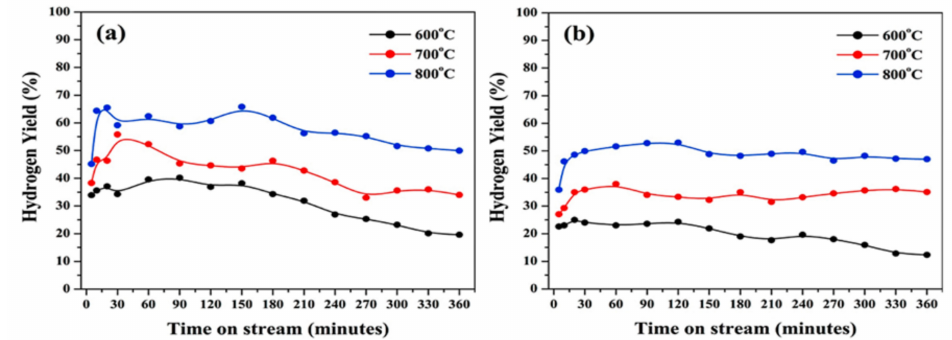
Figure 12. Catalytic activity tests carried out using ( a ) a NiO catalyst and ( b ) a Fe 2 O 3 catalyst; reprinted with permission from ref. [97]. Copyright 2016